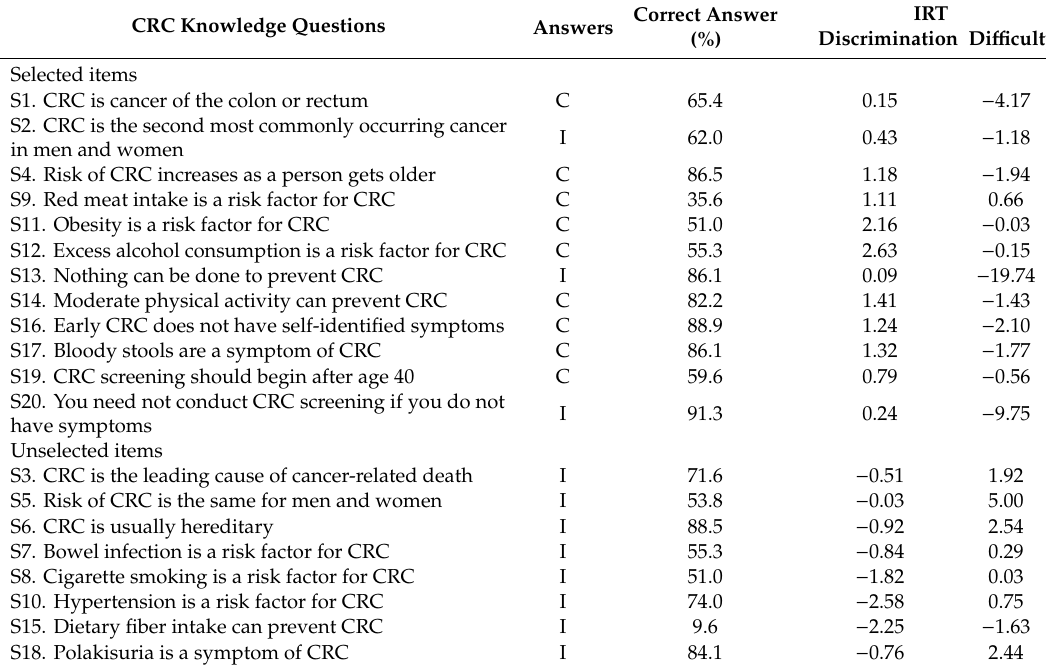
Table 2. Colorectal cancer (CRC) knowledge questions and